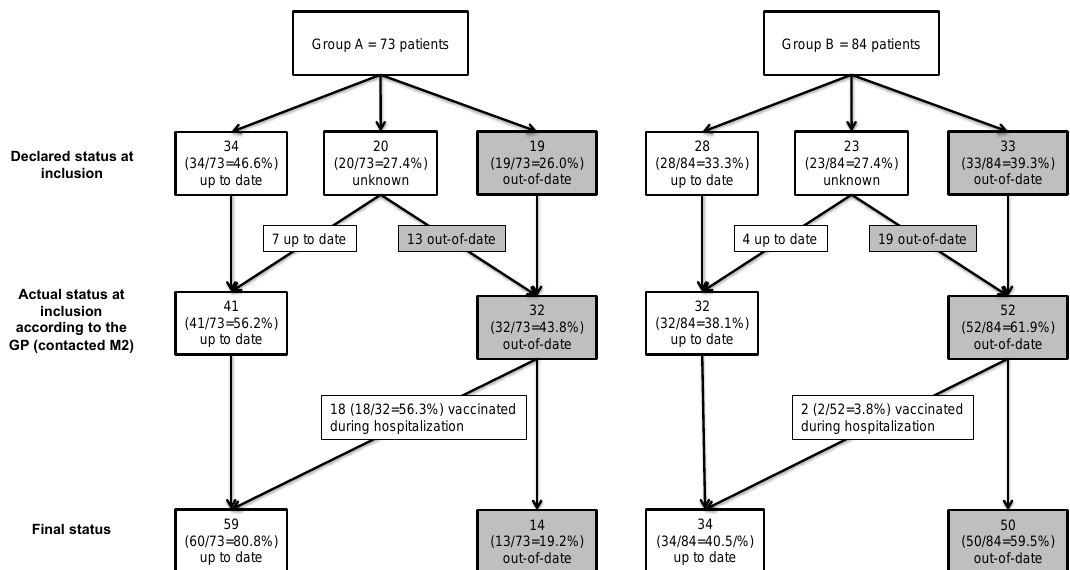
Figure 4. DT-IPV vaccination status and vaccination of patients included in the HOSPIVAC